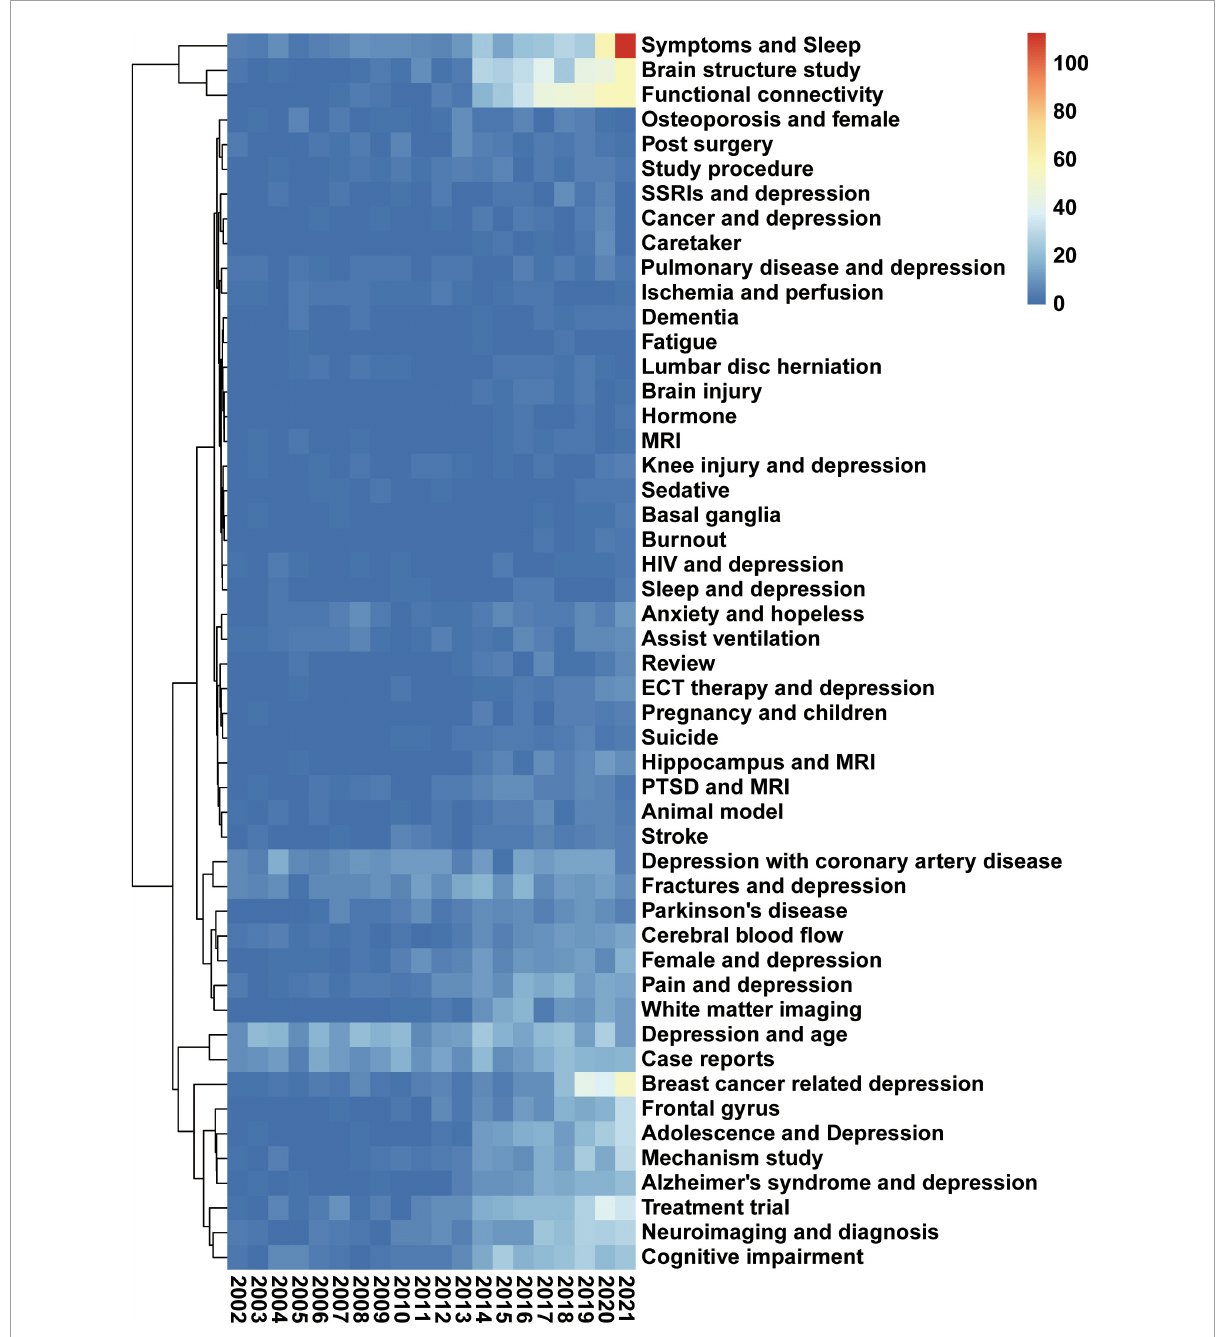
FIGURE6 “Symptoms and sleep,” “Brain structure study,” and “functional connectivity.” The heatmap presents the change of 50 research topics over the past 20 years. Data were generated by the use of the LDA algorithm. The abscissa represents the year, the ordinate represents the topics, and the color brightness represents the number of publications and reflects the shift in research focus. The legend represents the number of publications per